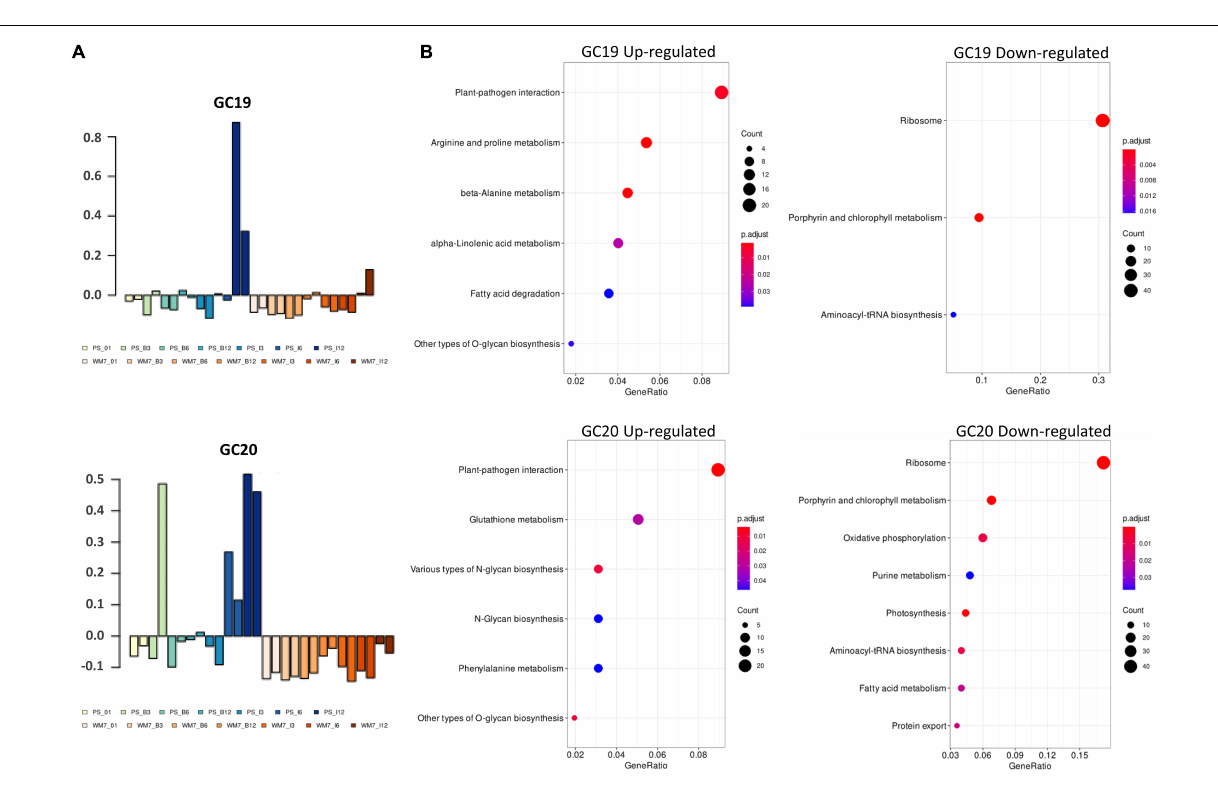
Frontiers in Plant Science |